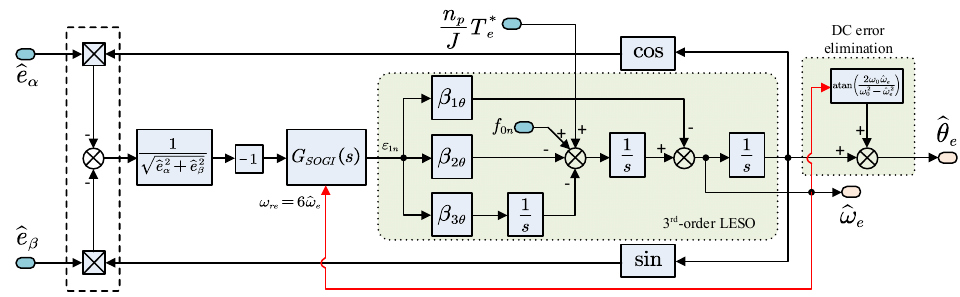
Figure 7. Diagram of the enhanced LESO-based QPLL with static-errorless position estimation.